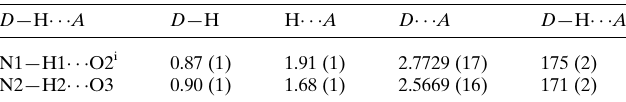
Table 1 Hydrogen-bond geometry (A˚ , (cid:4) ).